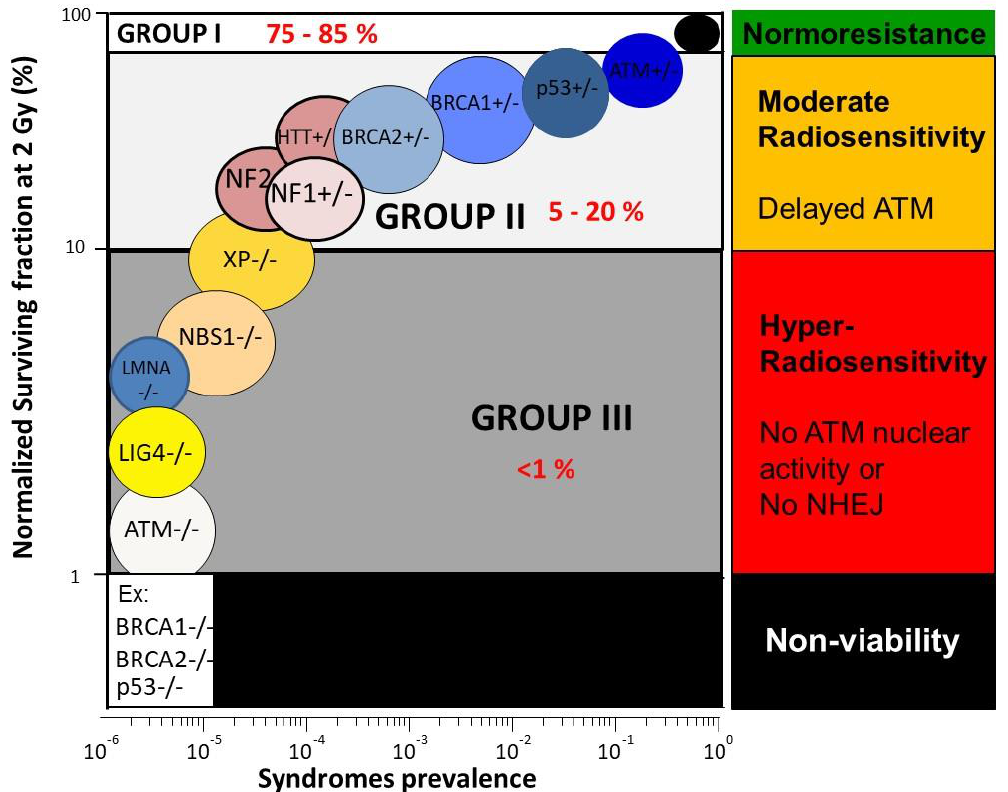
Figure 2. Cellular radiosensitivity as a function of syndrome prevalence. Survival fraction at 2 Gy (SF2) was fixed at 1% for ataxia telangiectasia mutated (ATM)-mutated cells and 100% for normosensitive patients. Each syndrome is represented by confidence zones. Data were taken from the databank of our lab and from [39].